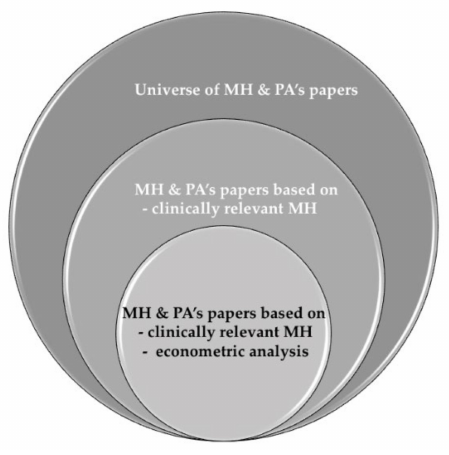
Figure 1. Evidence on MH and